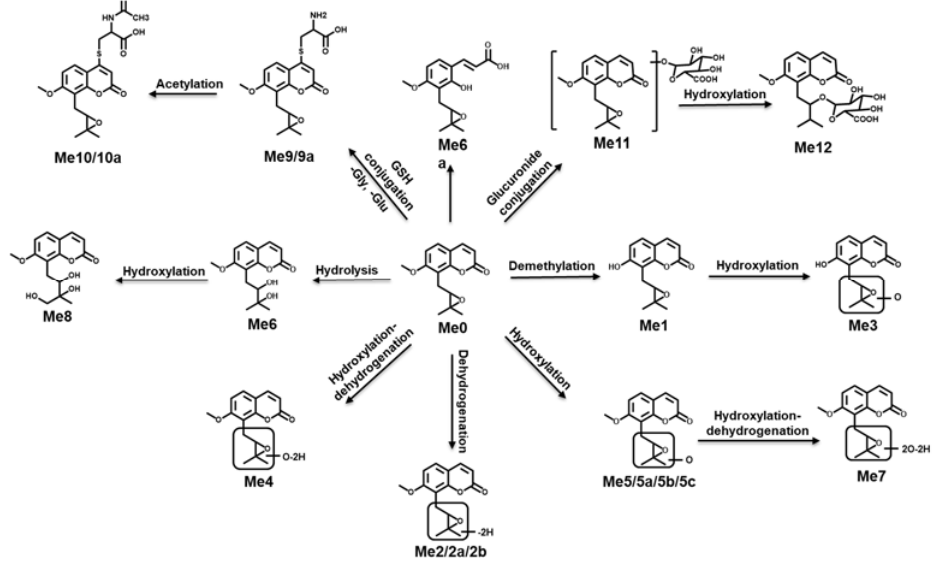
Figure 9. Metabolic map of MER.